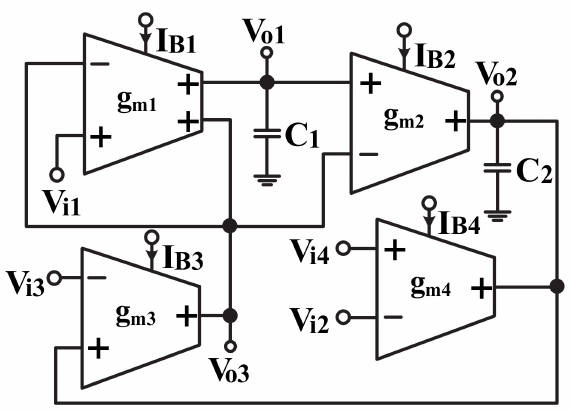
Figure 2. Proposed VM OTA-C